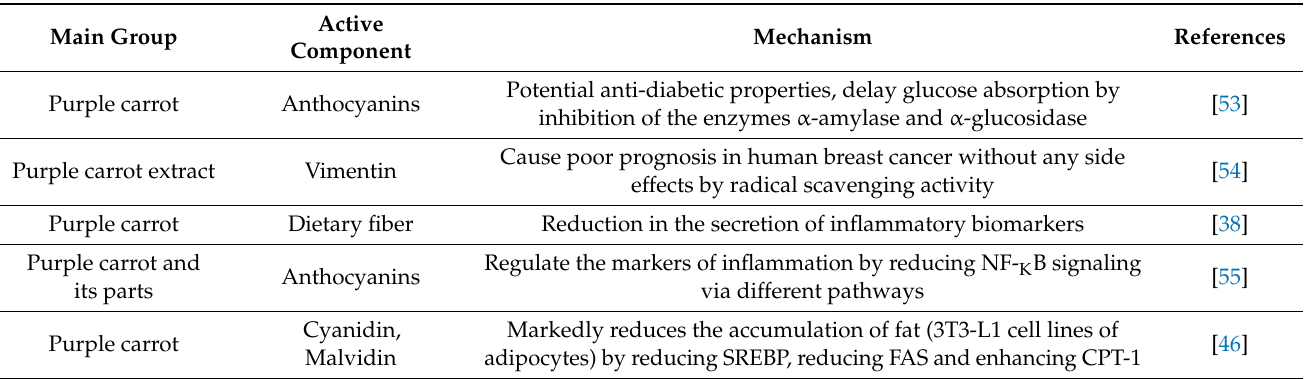
Table 3. The mechanism of purple carrot against MetS and